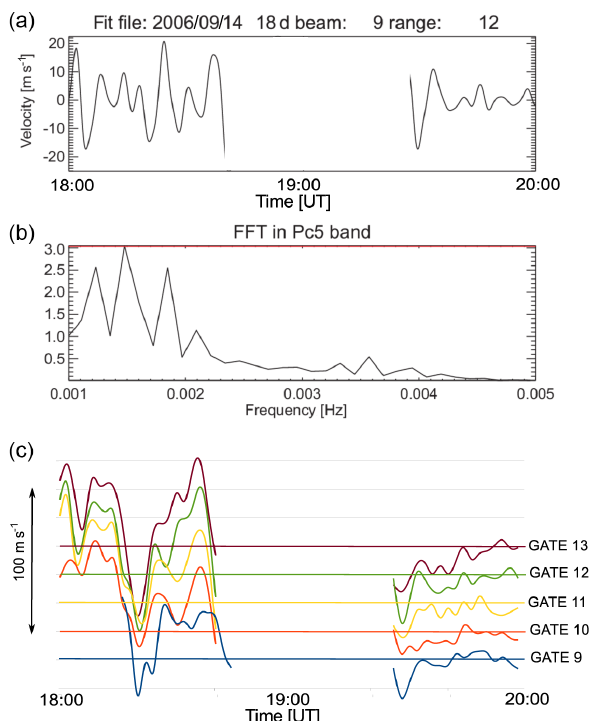
Figure 7. Event 3. The top panel (a) shows Pc5 band-filtered Doppler velocity data from the Sanae radar. The middle panel (b) contains the corresponding power spectrum together with the sig- nificant limit level from filtered data. The peak detector recorded the peak in frequency band 1.4–1.7mHz as significant. The bottom panel (c) is a stack plot of the velocity data in the range gates show- ing the strongest